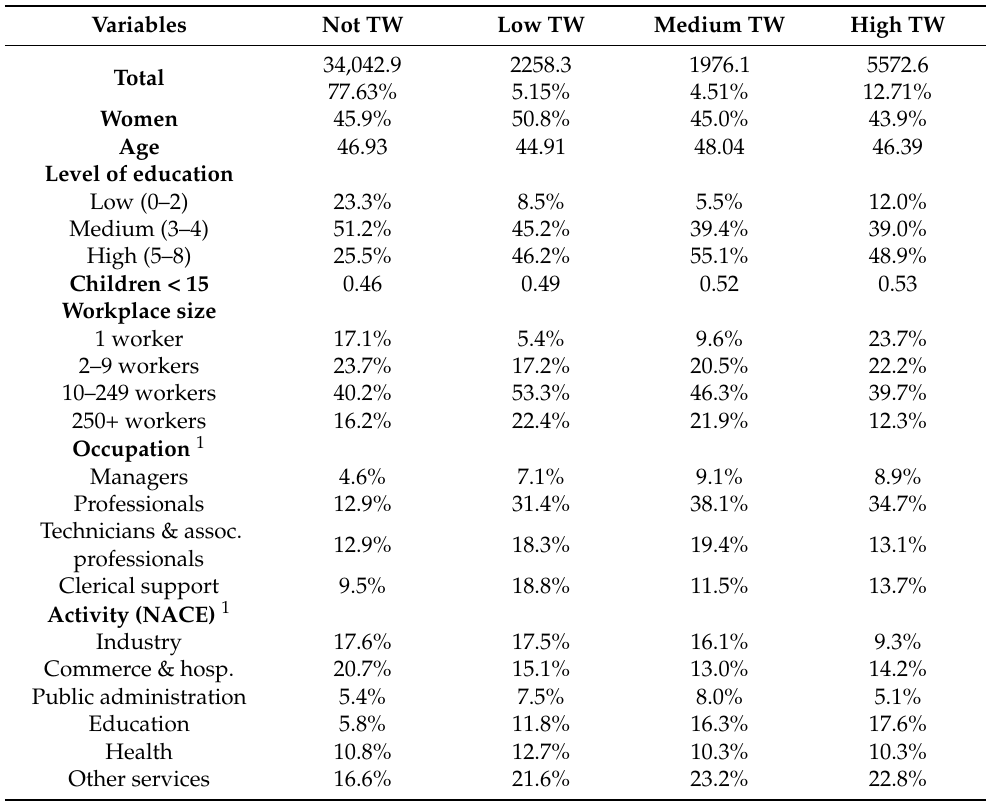
Table 1. Descriptive statistics on the sample by intensity of teleworking (weighted) in 35 European countries (mean values or frequencies in %). Source: Own elaboration based on